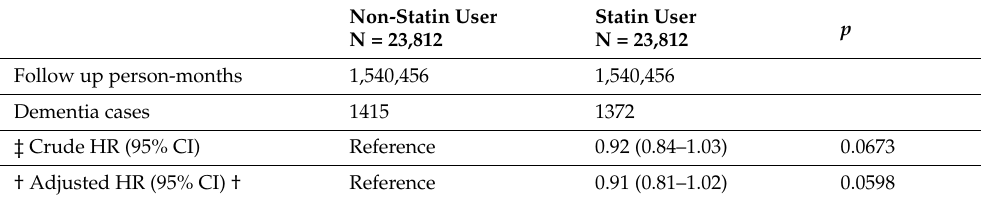
Table 3. Sensitivity analysis of incidence and risk of dementia after Propensity Score matching.